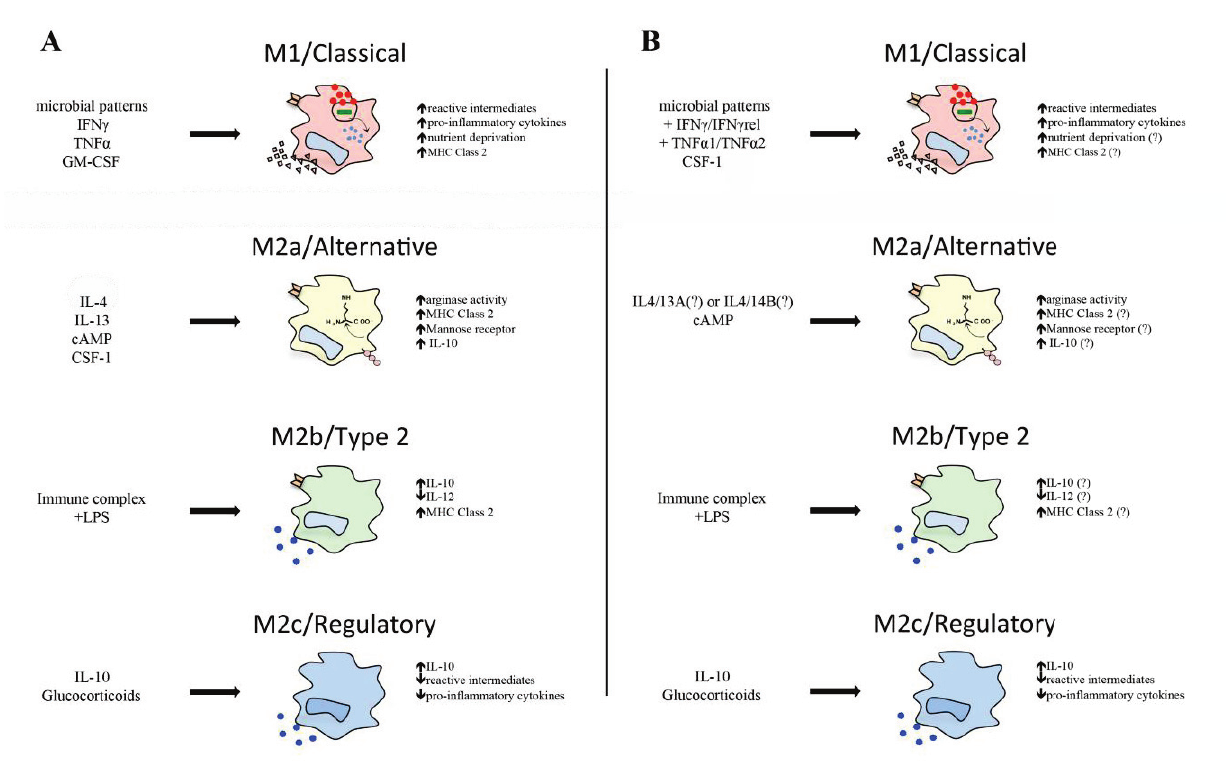
Figure 1. ( A ) Activation states of mammalian macrophages. Stimulation with microbial patterns in addition to type II interferons, TNFα or GM -CSF, leads to increased antimicrobial responses of macrophages, pro-inflammatory cytokine production, and nutrient deprivation in accordance with an M1 activation profile. Alternative activation of macrophages by cAMP IL4 and/or 13 ligands results in increased arginase expression and activity. Stimulation with immune complexes and lipopolysaccharides (LPS) generates a unique IL-10 high IL-12 l ° w M2b phenotype. IL-10 or glucocorticoid-activated macrophages drive regulatory function, inhibiting pro-inflammatory cytokine production, antimicrobial activity, and driving IL-10 expression; ( B ) Activation states of teleost macrophages. Stimulation